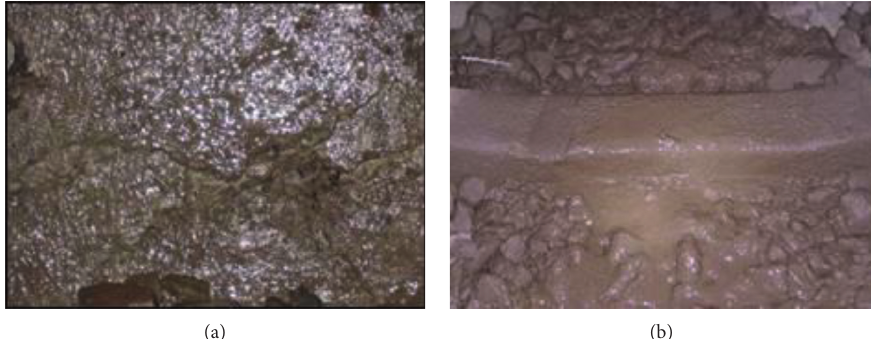
Figure 1: Crack and water leakage of tunnel bottom structure.